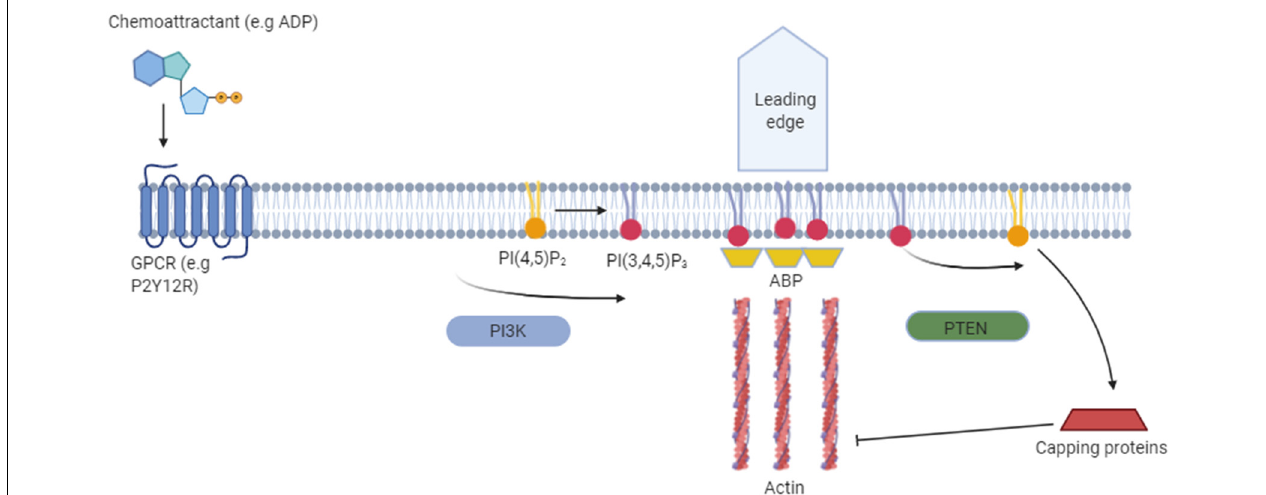
FIGURE 3 | Functional role of phosphoinositides in cell migration. The binding of a chemoattractant to G-protein coupled receptors (e.g., P2Y12R) in the cell membrane releases the G α heterodimer from the heterotrimeric G α proteins. Dissociated G α proteins stimulate PI(3,4,5)P 3 production from PI(4,5)P 2 via phosphoinositide 3-kinase (PI3K) and lead to membrane translocation of PI(3,4,5)P 3 -binding actin-binding proteins (ABPs) such as myosin. This allows remodeling of the actin cytoskeleton at the leading edge, which is required for the formation of novel cell protrusions. Away from the leading edge PI(3,4,5)P 3 is converted back to PI(4,5)P 2 via phosphatase and tensin homolog (PTEN). PI(4,5)P 2 then inhibits actin assembly by binding capping